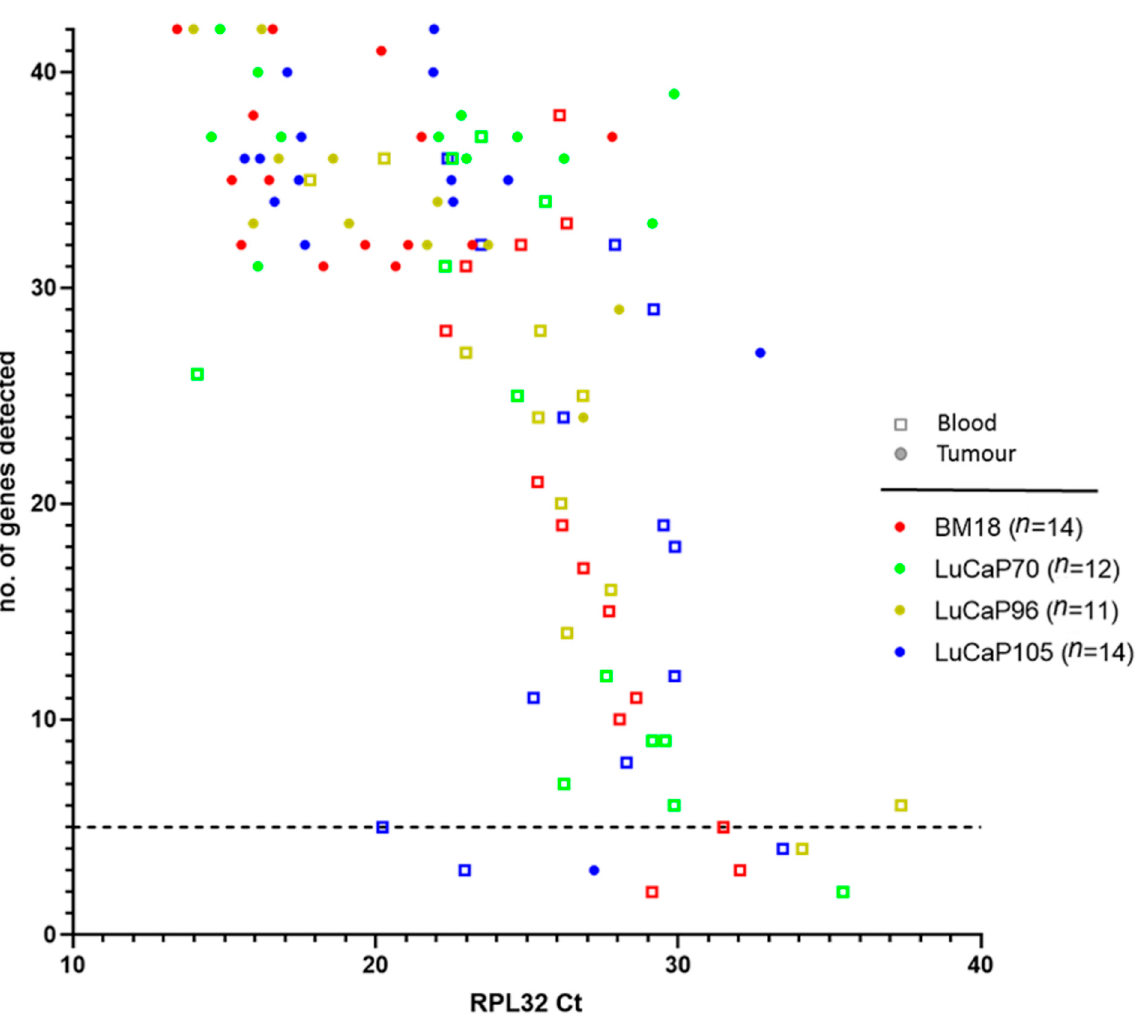
Figure 3. The number of genes detected in blood and tumour samples decreased sharply with lower expression of housekeeping gene RPL32 . The complete 42-gene human-specific nested RT-qPCR assay was performed on RPL32 -positive blood samples and their paired tumours. The number of genes detected in each sample was plotted against their raw cycle threshold (Ct) value of RPL32 . Smaller Ct values correspond to higher gene expression. n denotes number of blood and tumour pairs for each PDX. Dotted line indicates 5 genes detected.